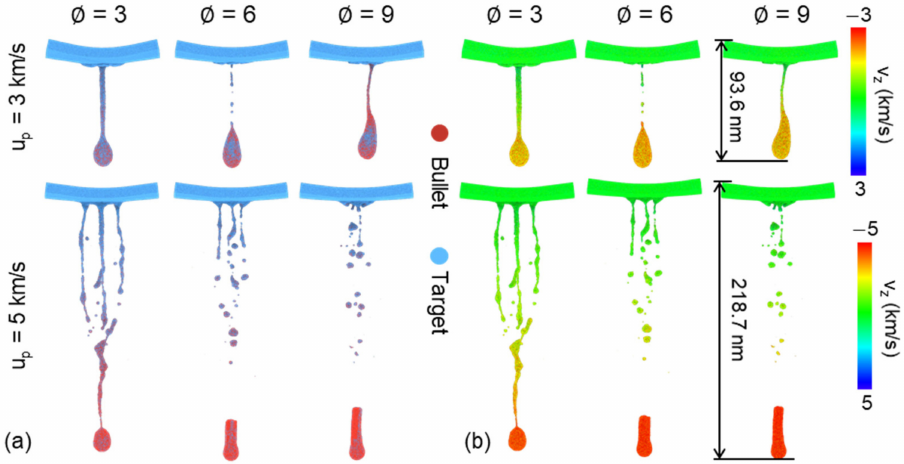
Figure 10. Microscopic views of final fragmentation (50 ps) for different draw ratio at the case of 3 and 5 km/s. Atoms are colored by ( a ) matter distribution and ( b ) velocity along impact direction. The number and size of cluster are further estimated based on the method used in works [10,44,45], as shown in Figure 11. N p indicates the atom number in each cluster and N c means the number probability in corresponding N p range. The number and size distribution exhibit similar features for all the cases. Previous works have shown the fragmentation distribution approximately manifests the power law decrease regulation in micro-ejecta or nanorod impact [10,44,45]. Here we use similar formula to fit original data: N c = aN b , where a and b are undetermined parameters. We take the case of 5 km/s as orig- p inal data because more fragmentation is formed at this incident velocity. Besides, N p < 1000 is not considered for the fitting, which is regarded as insignificant in the fragmentation pro- cess. The fitting results show that the fragmentation distribution in the penetration process also manifests this attenuation trend, as marked by dash line in Figure 11. Those results appear to reveal a universal regulation for fragmentation distribution under hypervelocity impact at